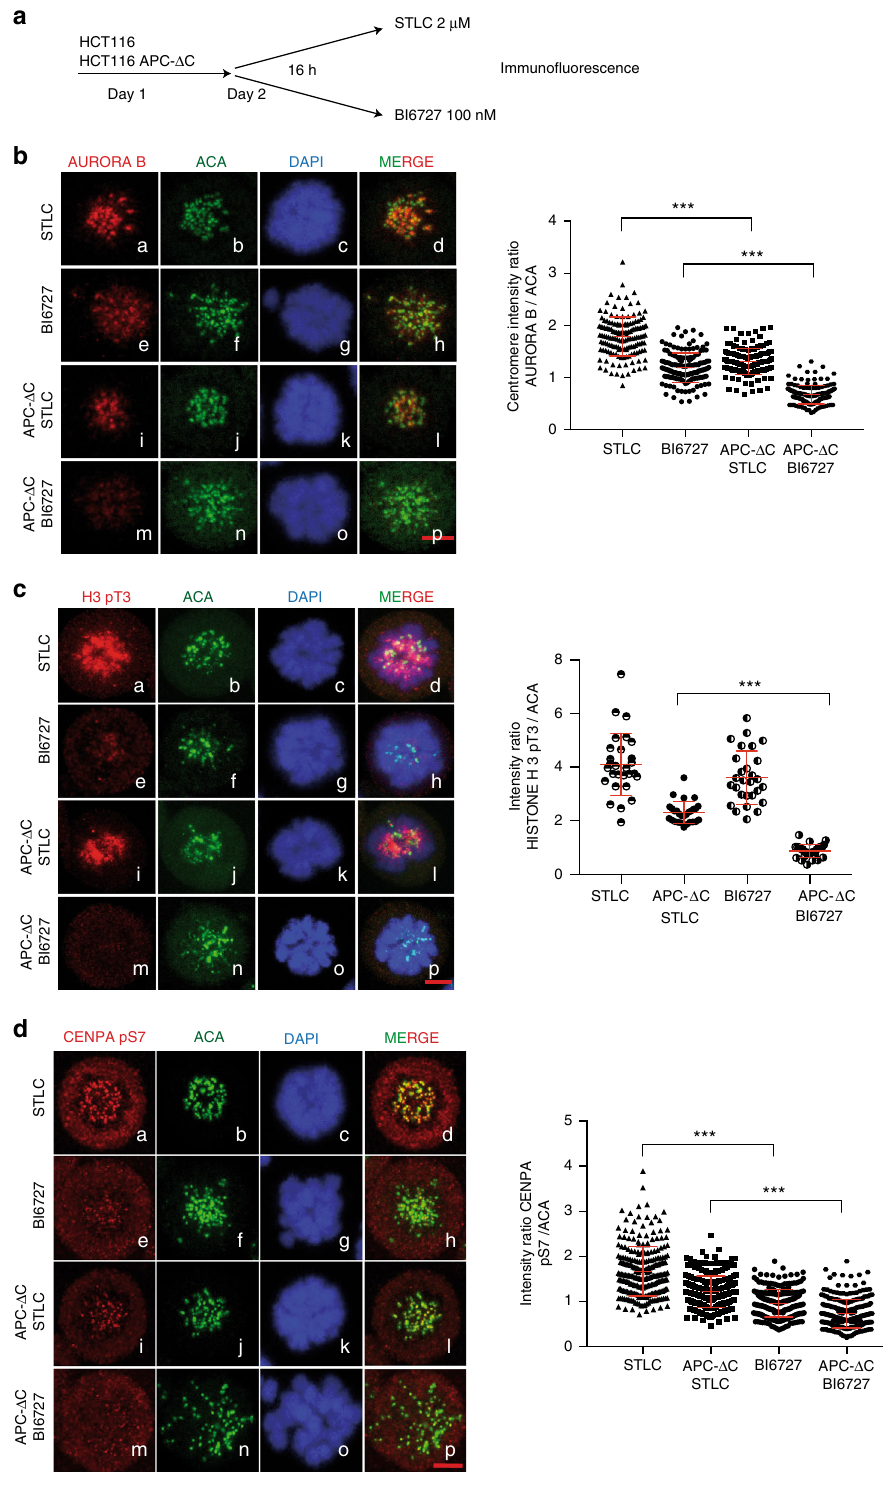
Fig. 6 Inhibition of PLK1 decreases the levels of Aurora B, CENP-A pS7 and Histone 3 pT3 in cells expressing APC- Δ C. a Scheme of the experimental procedure. APC- Δ C-expressing and control HCT116 cells were seeded on day 1, treated on day 2 either with 2 µ M STLC or 100 nM BI6727 for 16 h and harvested on day 3. Cells were fi xed, processed for immuno fl uorescence using antibodies for ( b ) Aurora B, ( c ) Histone 3 pT3 (H3 pT3), ( d ) CENPA pS7and ACA. Intensities were normalized to ACA and quanti fi ed. Scale bar, 5 µ m. Values were calculated from at least 50 cells per treatment. (means ± s.d., n = 3, for each treatment). *** P < 0.001, Mann-Whitney U